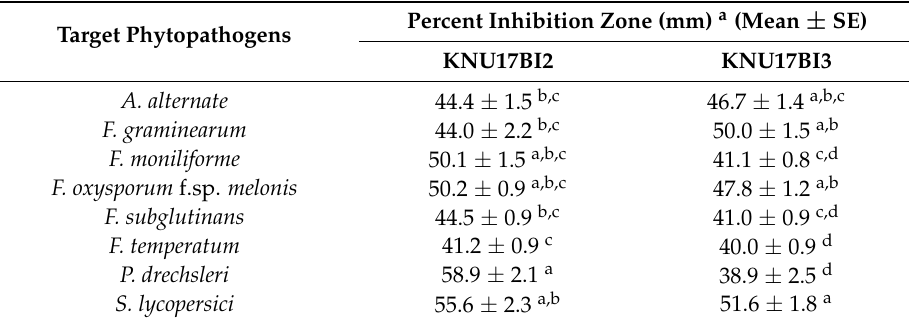
Table 3. Broad spectrum antifungal activity of the study Burkholederia strains.